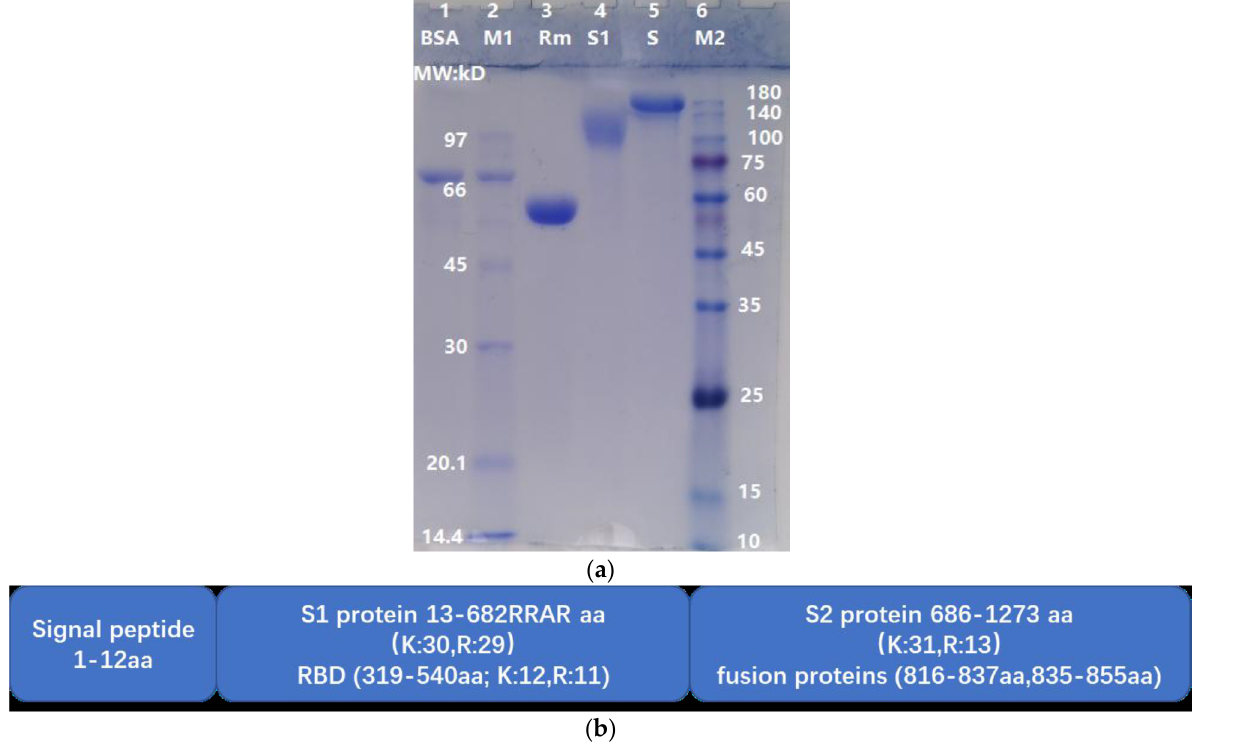
Figure 1. Molecular weight comparison of S, S1, and RBD-mouseFc by SDS-PAGE and